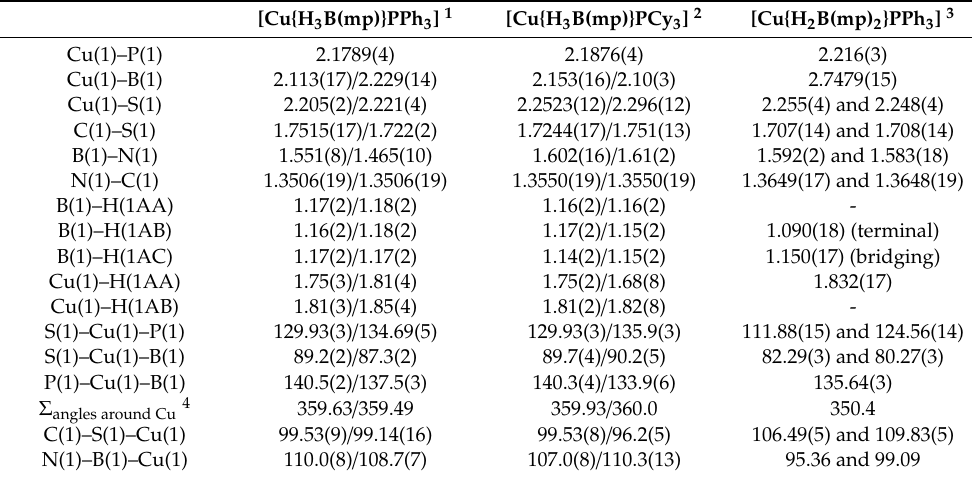
Figure 4. Two bonding descriptions for the [H 3 B(mp)] − .